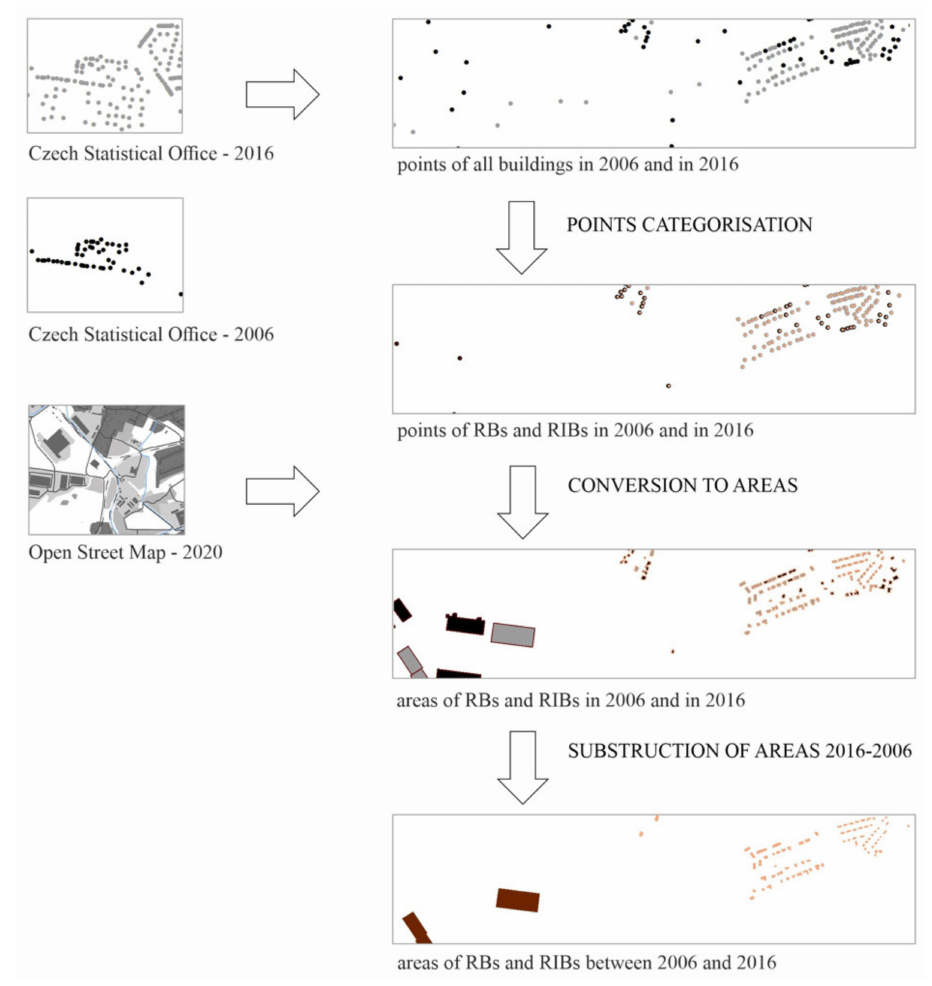
Figure 2. Data processing scheme of the building growth between 2006 and